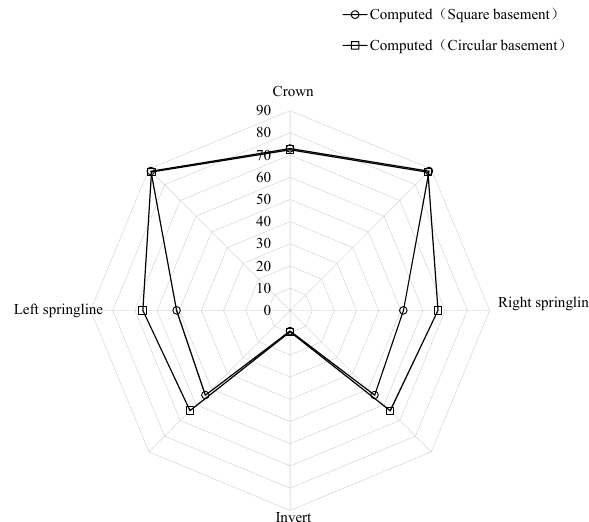
Figure 7. Earth pressure change around the tunnel lining (absolute value).